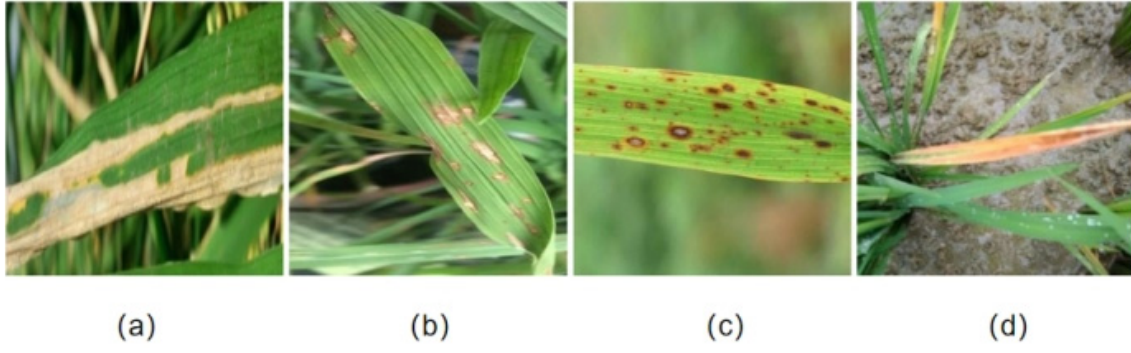
Figure 1. CBG-Dataset images ( a ) Bacterial blight; ( b ) Blast; ( c ) Brown spot; ( d ) Tungro.